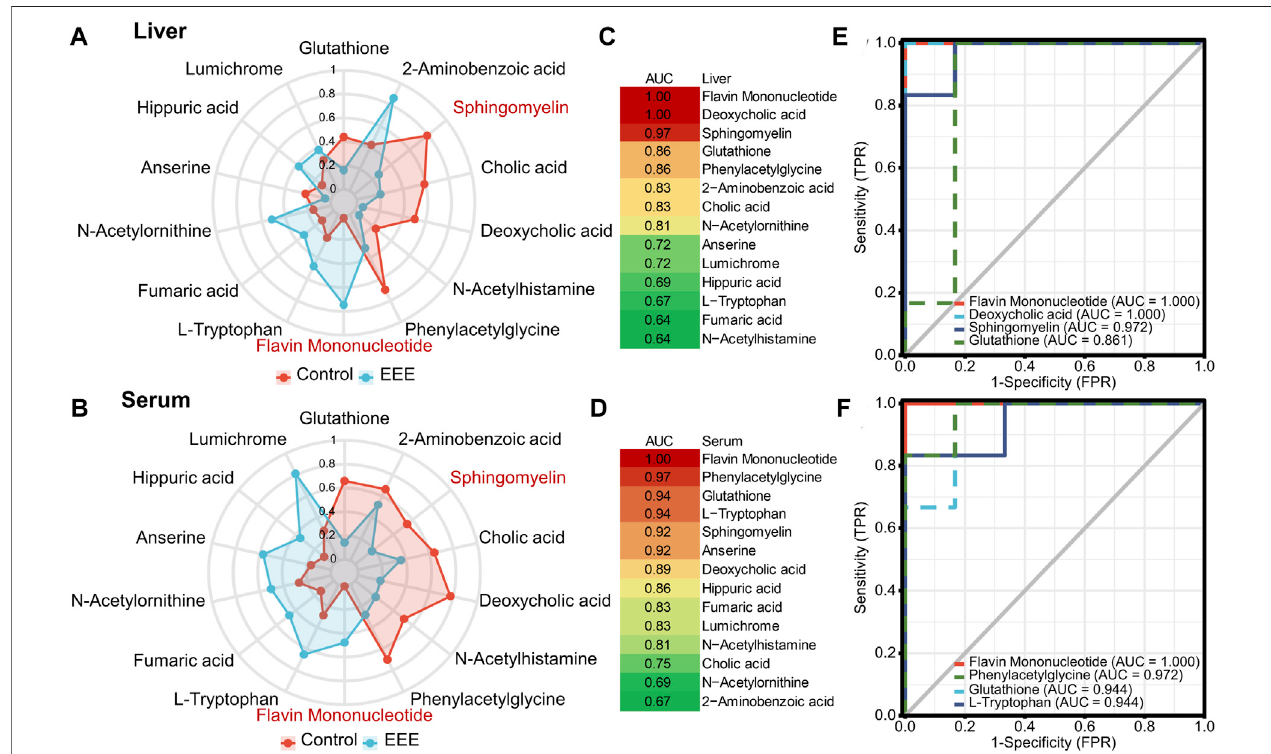
FIGURE 4| Screening for biomarkers associated with EEE-induced liver injury. (A,B) Spider plots of14 liver and serum shared differentially expressed metabolites betweentheControlandEEEgroups.Theredlinerepresentsthecontrolgroup,andthebluelinerepresentstheEEEgroup. (C,D) HeatmapofAUCvaluesof14liverand serum shared differentially expressed metabolites. (E,F) ROC curves of differentially expressed metabolites with top 4 AUC values in liver and